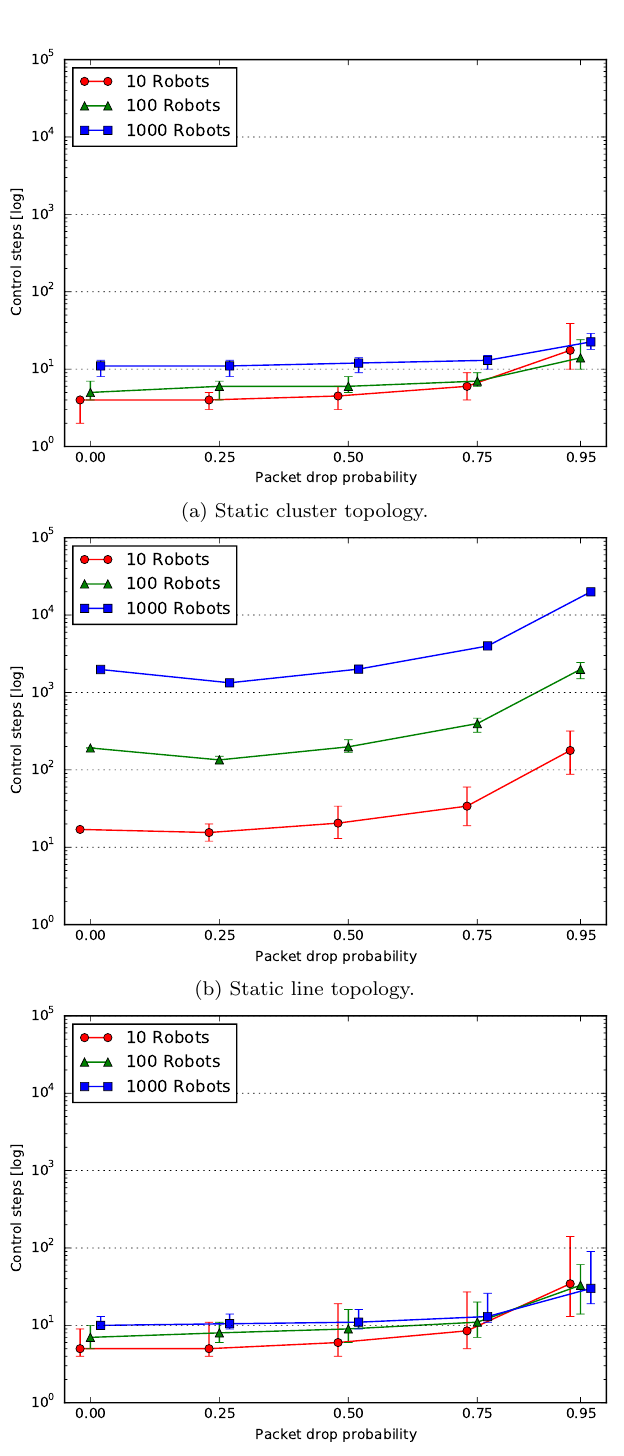
(c) Static scale-free topology. Figure 3: Convergence time (in control steps) for static topologies in different experimental configurations. The plot reports the median, max, and min values of the distributions obtained for each experimental configuration (cid:104) N, P, topology (cid:105) over 50 runs. The markers are slightly off- set to make them